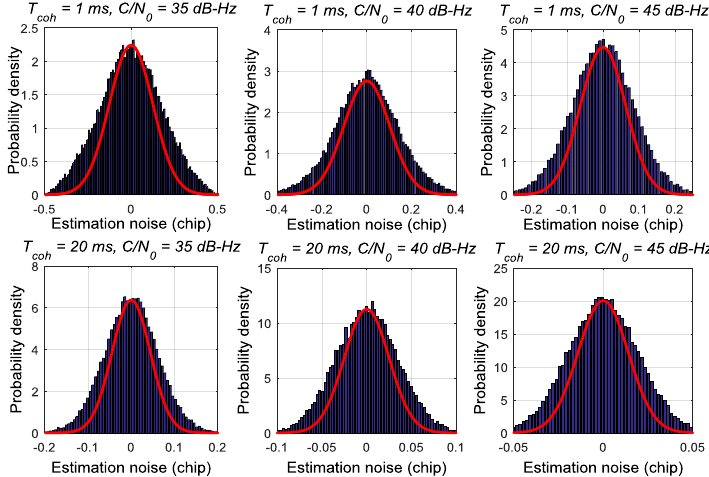
Figure 4. The estimation noise distribution of NC-EMLE discriminator in different T coh and C / N 0 .